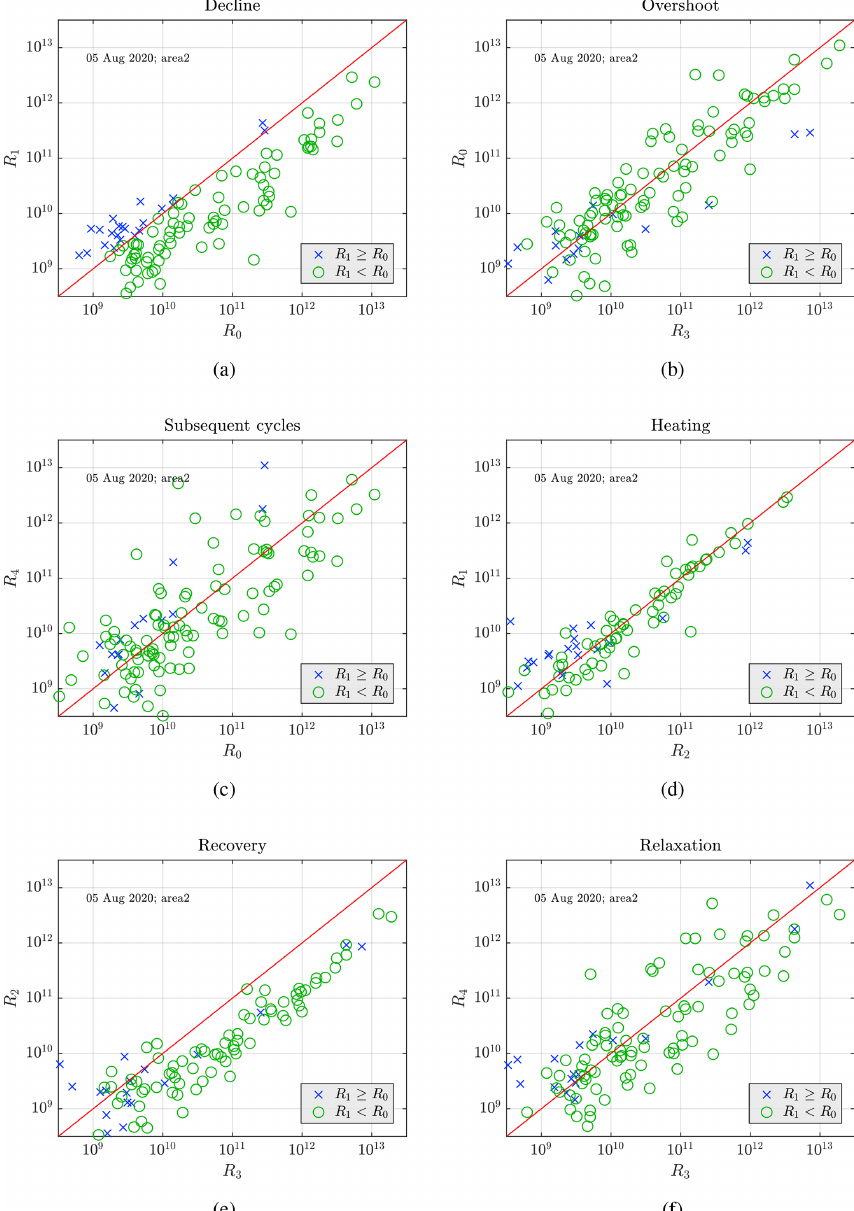
Figure 7. Comparison of the power amplitudes observed on 5/6 August 2020, area